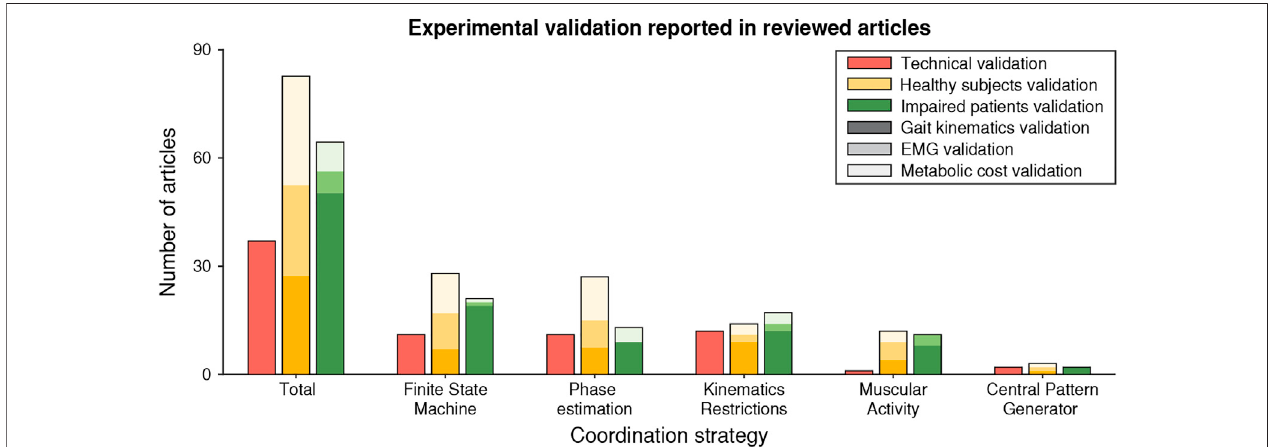
FIGURE 11 | Experimental validations of the proposed coordination strategies. We represent the overall distributions and the detailed distributions for each of the fi ve main coordination methodologies. Each color (red, amber, and green) represents a kind of validation (technical, with unimpaired walking subjects, or with impaired walkingsubjects,respectively).Thelightness ofthecolorindicatestheoutcomeused during thevalidation:darkest,medium,and lightestcorrespondtogaitkinematics, EMG, and metabolic cost validations,